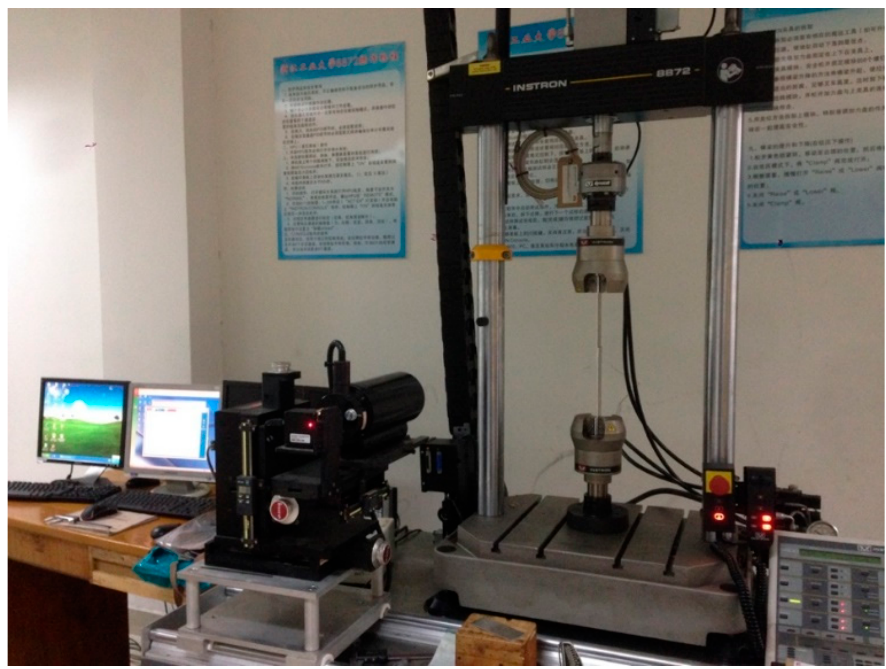
Figure 14. Schematic diagram of fatigue test system: Instron 8872 Fatigue Test System.